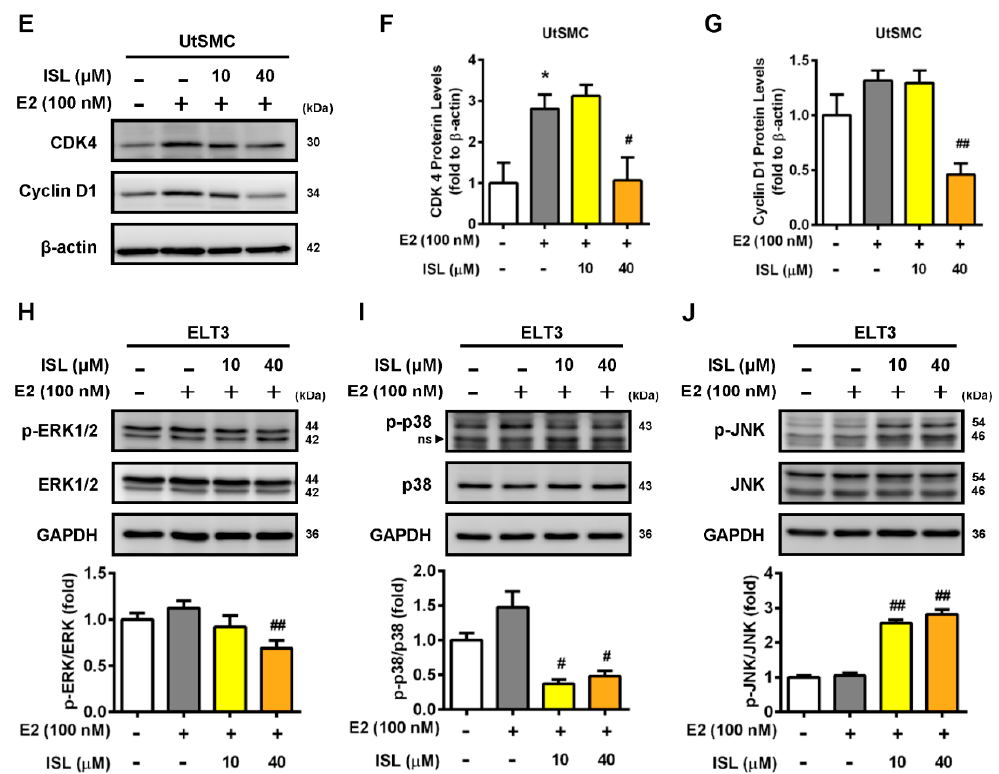
Figure 4. Determine the cell cycle distribution of ELT3 and UtSMC cells by ISL treatment. ( A ) ELT3 and UtSMC cells were treated with E2 (100 nM) alone or a combination of E2 and ISL (10 or 40 µ M) for 48 h. Cells were stained with propidium iodide, and the cell cycle distributions were analyzed by flow cytometry. ( B – D ) The quantitative data of cell distribution in ELT3 and UtSMC cells was shown. ( E – G ) UtSMC cells were co-treated with E2 and ISL for 48 h. The expressions of cyclinD1 and CDK4 protein in UtSMC cells were analyzed using Western blot. Each target protein was normalized to β -actin expression. ( H – J ) ELT3 cells were co-treated with E2 and ISL for 48 h. The expressions of MAPK proteins were analyzed using Western blot. Each target protein was normalized to GAPDH expression. Data are represented as means ± SEM. * p < 0.05 compared with the control group. # p < 0.05, ## p < 0.01 compared with the E2-treated group.